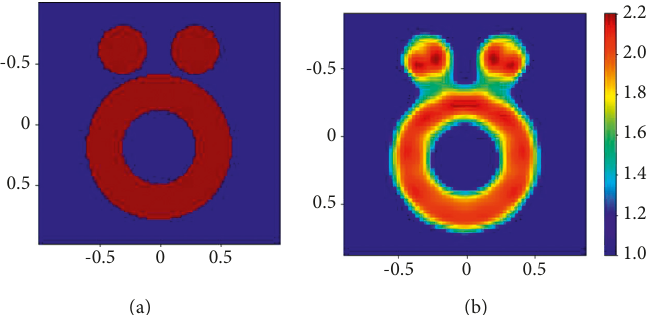
Figure 2: (a) The exact profile of the ‘Austria’ and (b) original CSI inversion result of the relative permittivity ε of